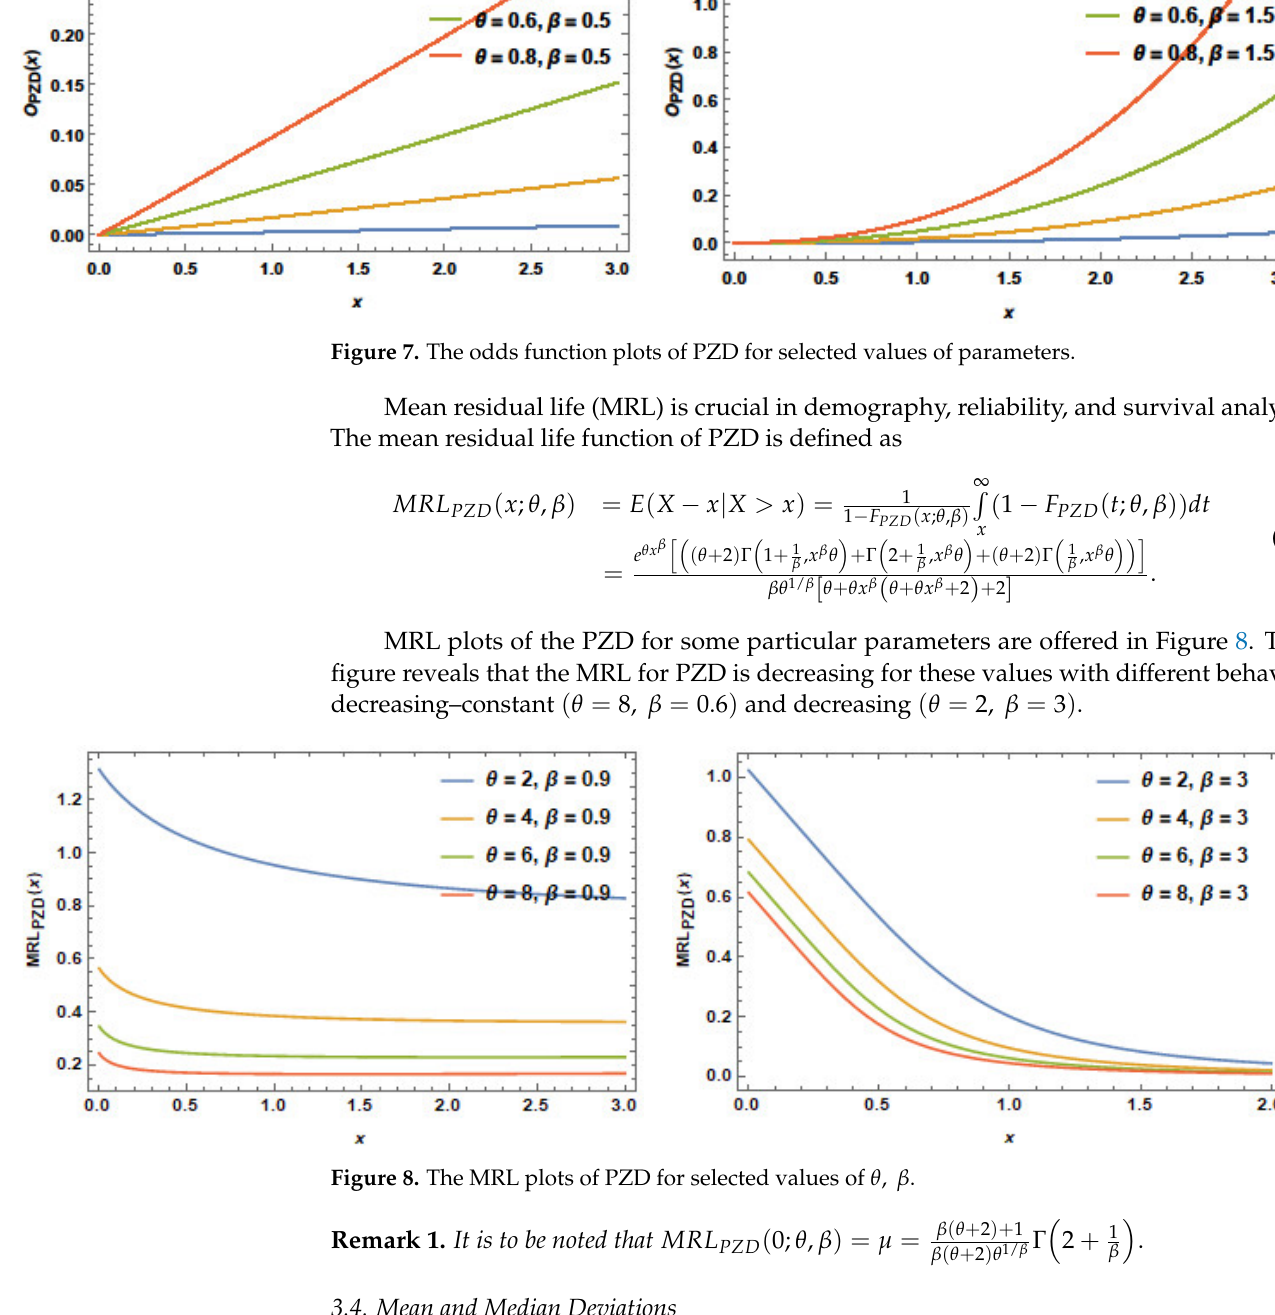
Figure 6. The RHF plots of PZD for various values of parameters.